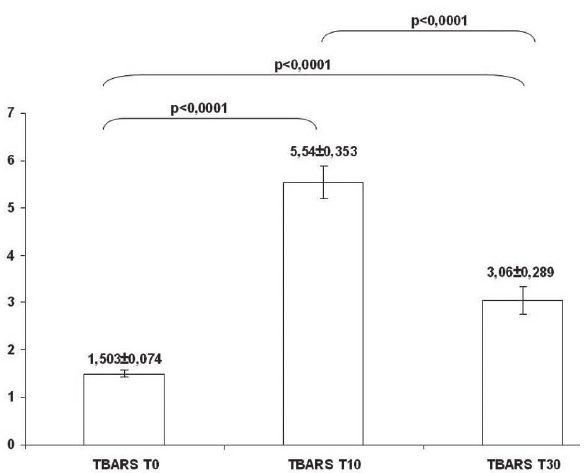
Fig 1. Medians and standard deviations of the doses of TBARS (mmoles/mg of serum protein) in the 25 blood samples collected at T , T and T 0 10